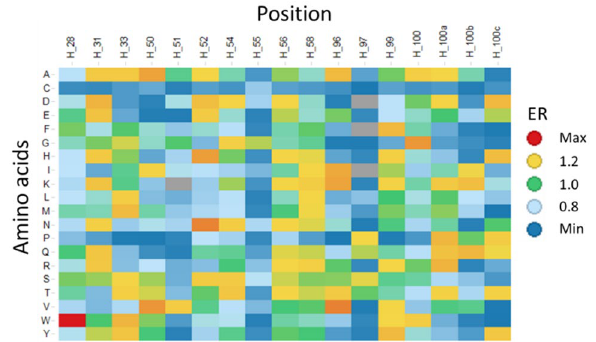
Figure 5. Enrichment ratio of diversified residues through panning. Enrichment ratio was calculated by NGS read counts with respect to each antibody numbering position. The ratio of amino acid compositions in diversified positions between two round kynurenine panning library and primary library is illustrated by heat- map.